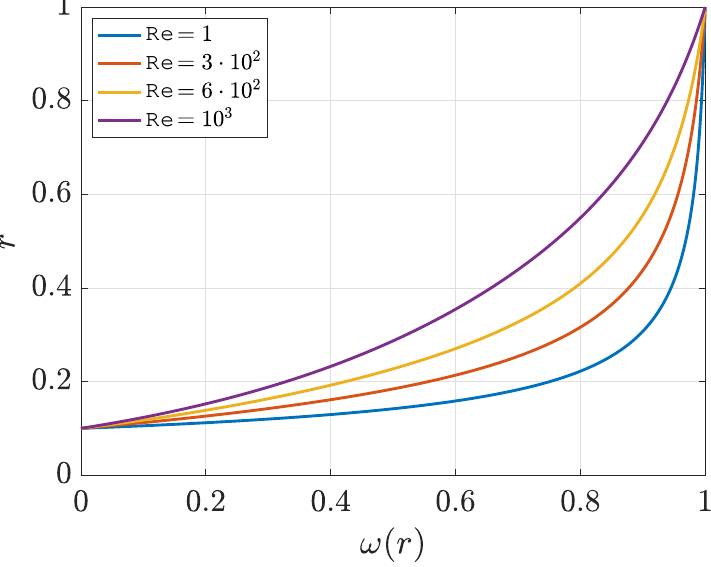
Figure 7. Angular velocity (31) for various Re < Γ 2 , Γ = 15, R 1 =